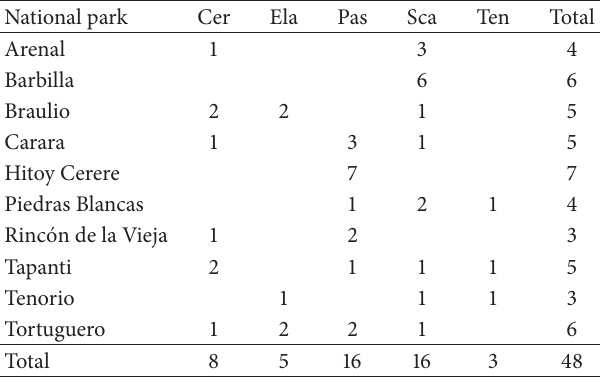
Table 2: Distribution of the number of larvae samples according to theinsectfamilyandnationalpark. Ateachsite,anapproximatearea of 150.000 m 2 was explored for the presence of wood-feeding larvae. The number of insect groups found varied according to the natural condition of each forest. Each sample was composed of one to three individuals of the same